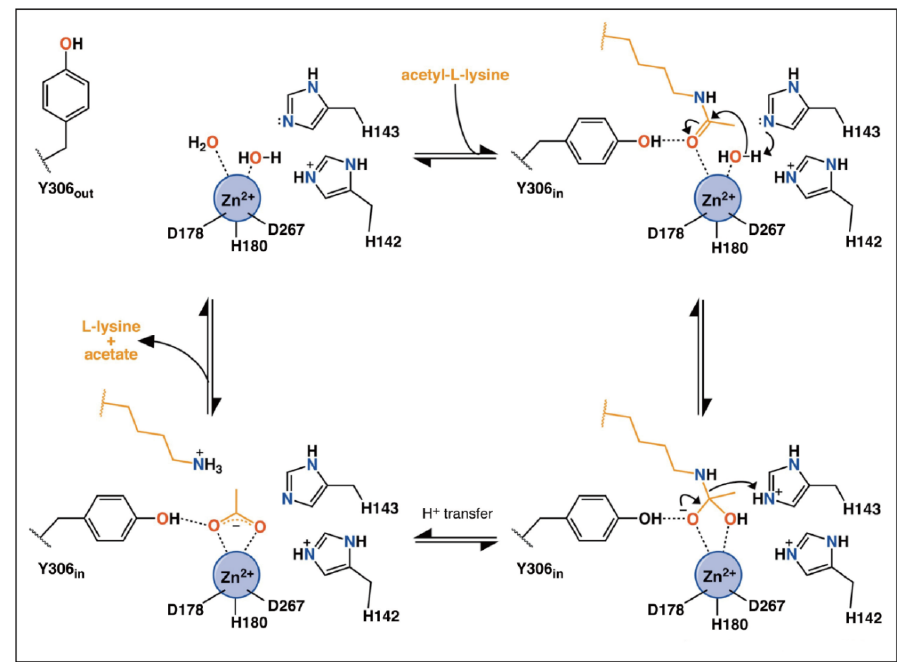
Figure 3. Possible mechanism of catalysis by HDAC8. Adapted with permission from Porter 2019 [66] .